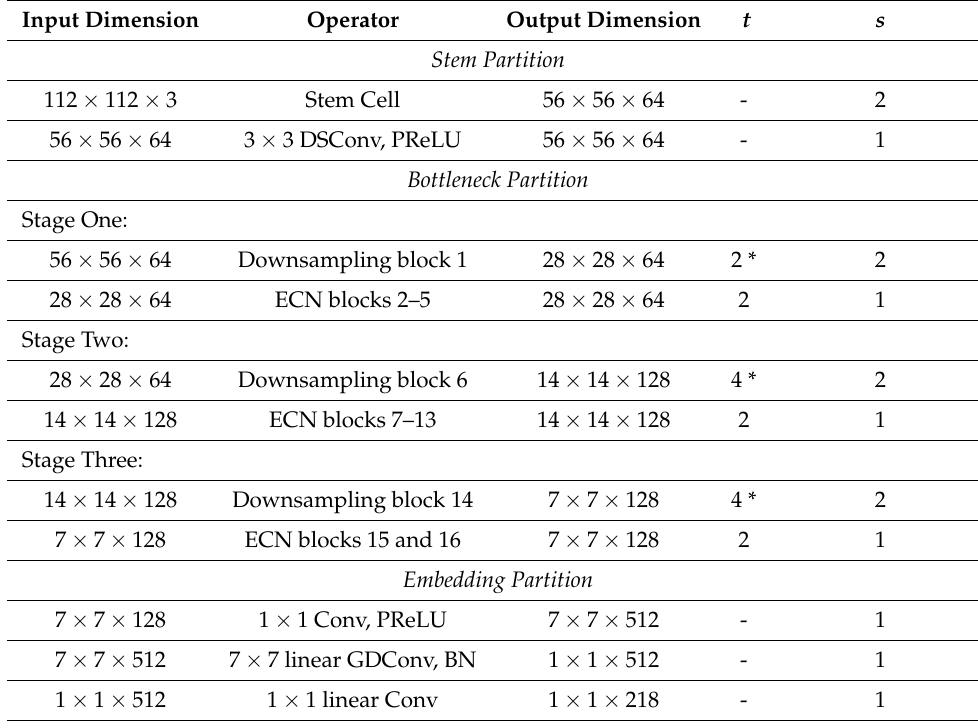
Table 3. Tabulated outline of the proposed ConvFaceNeXt model. Each row denotes a sequence of operators. Here, t denotes the expansion factor for downsampling and ECN blocks. Note that for the downsampling block, the expansion factor only applies to the ED block (shown with *), while there is none for the SD block. In addition, a stride s of two is set for all the downsampling blocks, while the other ECN blocks use a stride of